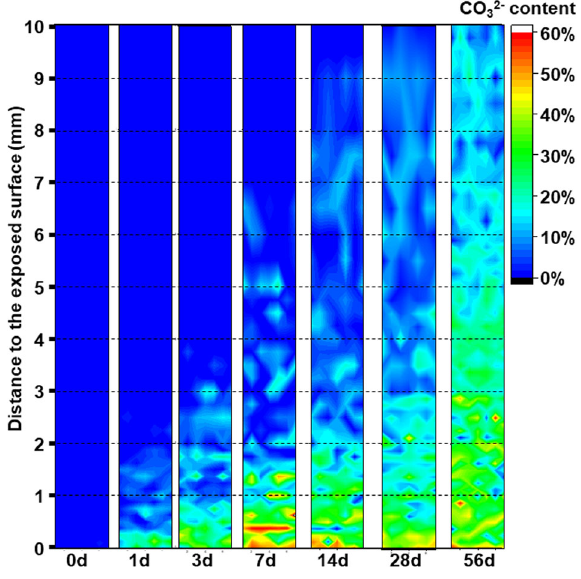
Fig. 3 Raman mapping showing the carbonation degree of the specimen after different ages of accelerated carbonation. Differ- ent colors representing the CO 32 − converting from the intensity of Raman peak at 1084 cm − 1 by using the correlation obtained from Fig. 2c.